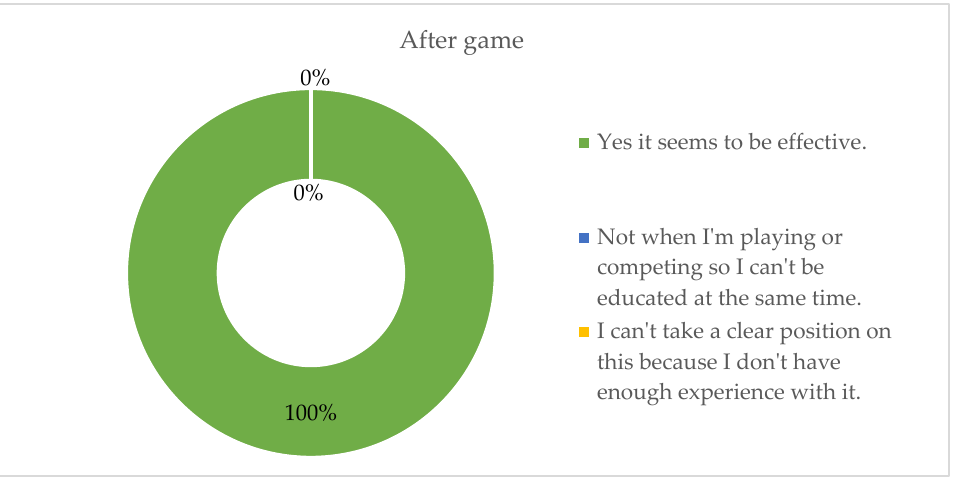
Figure 6. Results of questionnaire for question: Is it effective to educate in the form of a competition or a game? (after using toolkit).